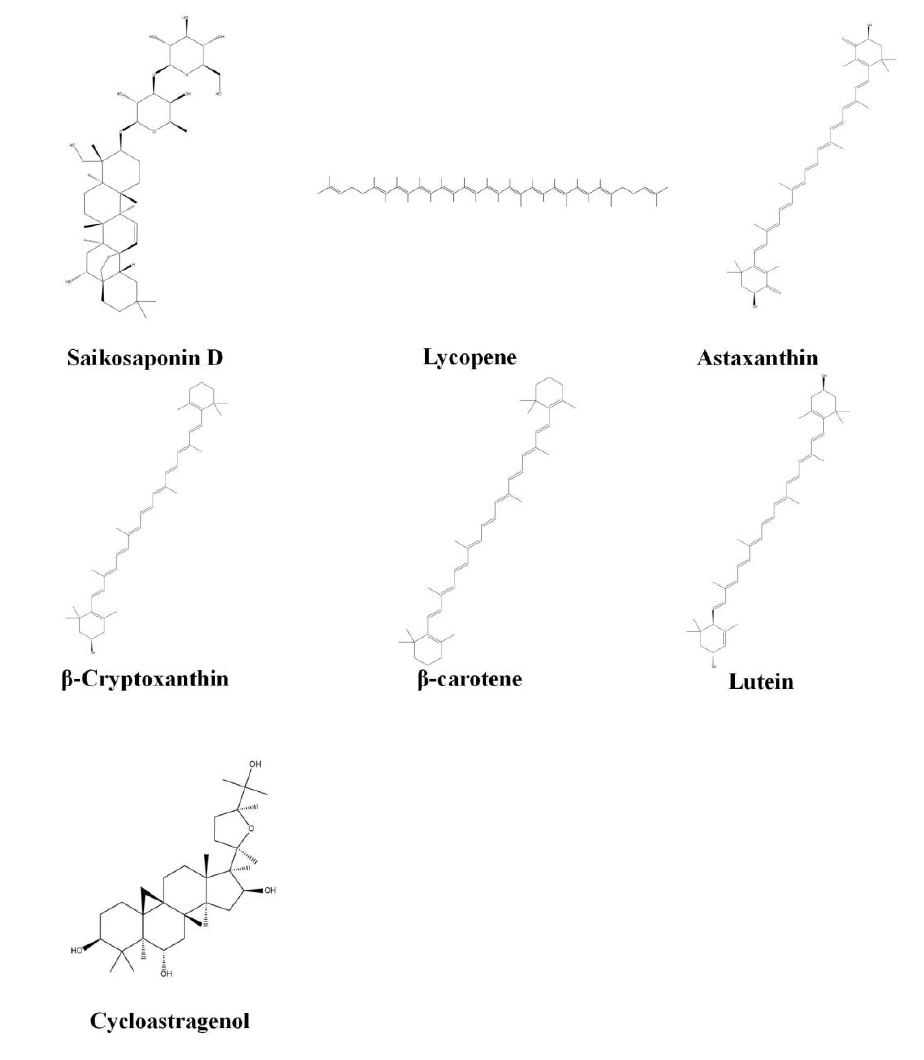
Figure 2. Chemical structure of